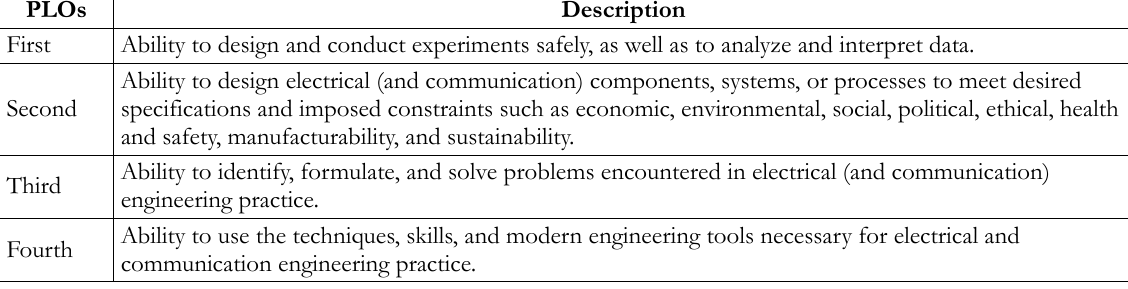
Table 1. The program learning outcomes addressed by the lecture-based and laboratory-based courses